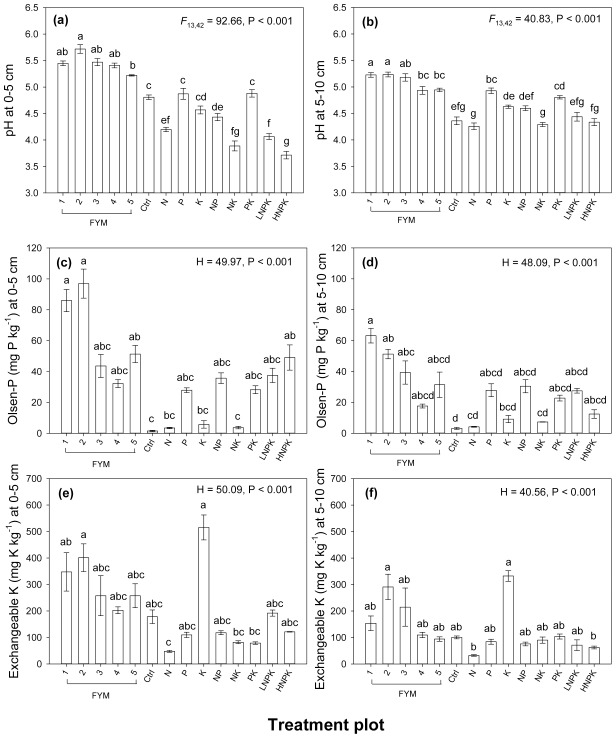
Effect of fertilizer treatment plot on (a) soil pH at 0–5 cm, (b) soil pH at 5–10 cm, (c) Olsen-P at 0–5 cm, (d) Olsen-P at 5–10 cm, (e) exchangeable K at 0–5 cm and (f) exchangeable K at 5–10 cm. Error bars represent ±1 standard error of the treatment plot mean and contrasting letters denote significant differences between treatment plots. H is the Kruskal-Wallis test statistic.